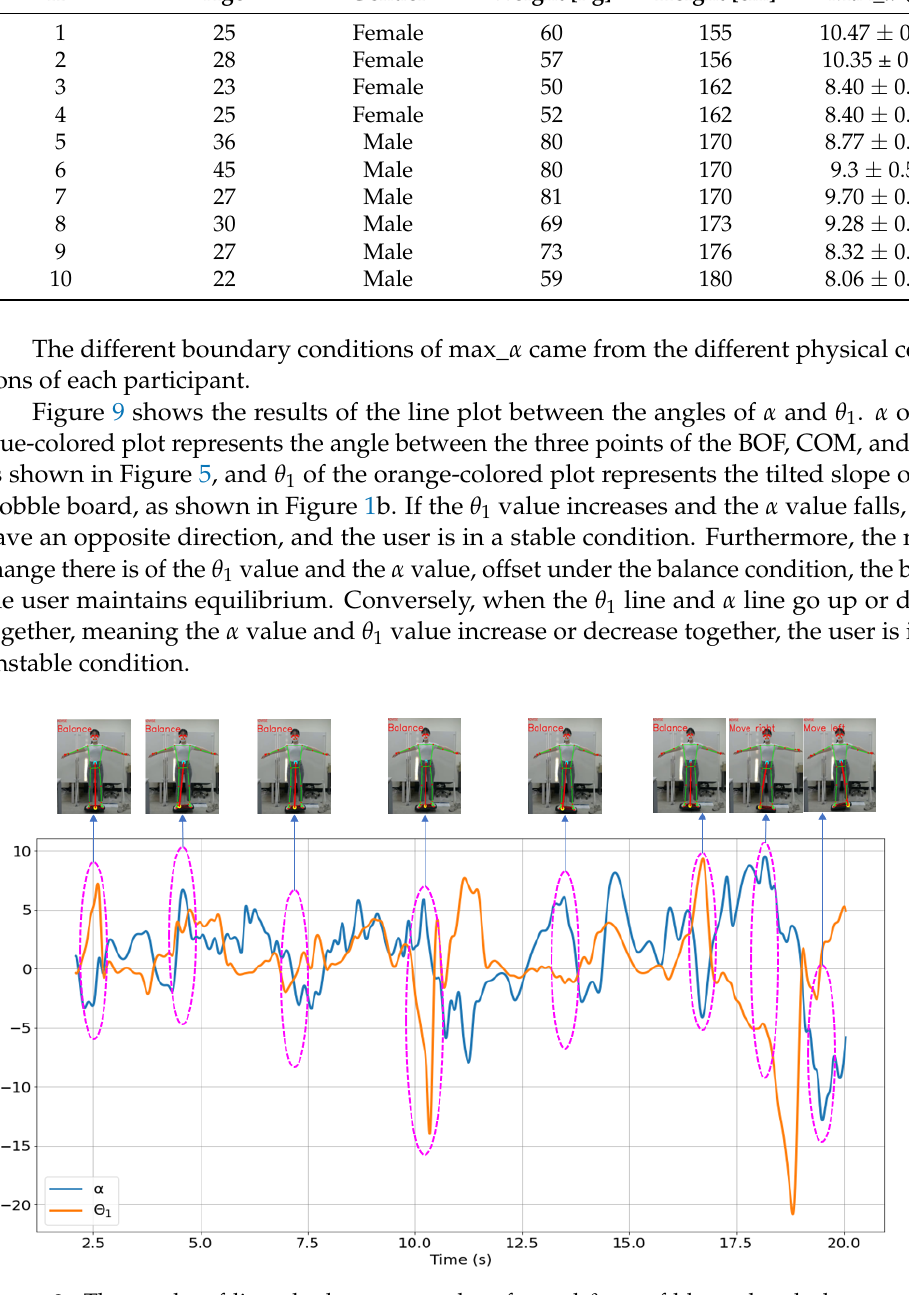
Figure 9. The results of line plot between angles of α and θ 1 : α of blue-colored plot represents the angle between three points of the base of the foot (BOF), the center of mass (COM), and the perpendicular-projection point (PPP), while θ 1 of orange-colored plot represents the tilted slope of the wobble